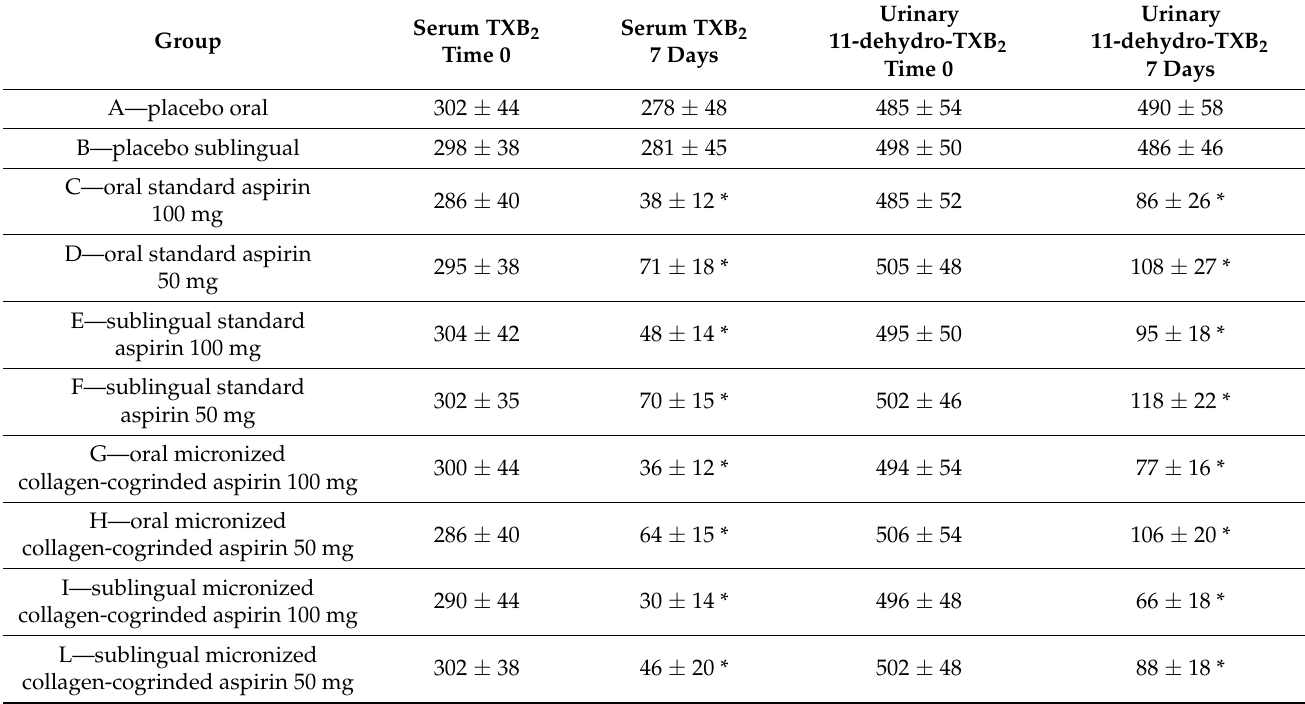
Table 2. The effect of standard aspirin, collagen-cogrinded aspirin and placebo, given orally or sublingually to healthy volunteers, on serum TXB 2 (ng/mL) and urinary 6-dehydro-TXB 2 (pg/mg cre- atinine) at Time 0 before treatment and after 7 days of treatment. Values are expressed as mean ± SD * p < 0.05 treatment vs.